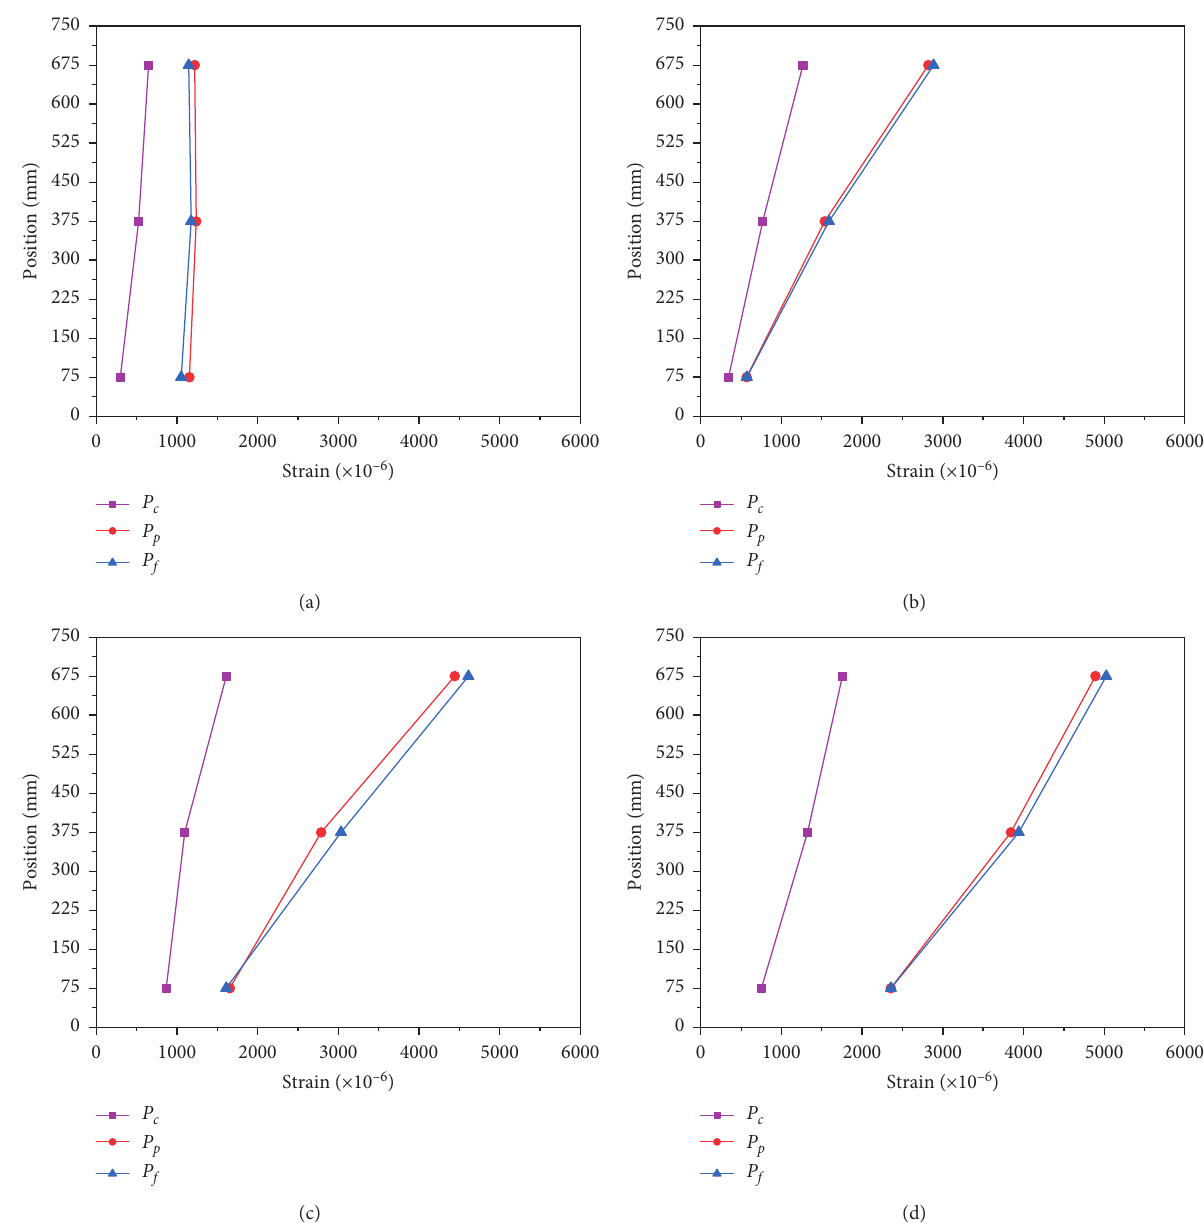
Figure 16: Strain distribution of longitudinal reinforcement: (a) GJ, (b) ZJA, (c) ZJB, and (d)